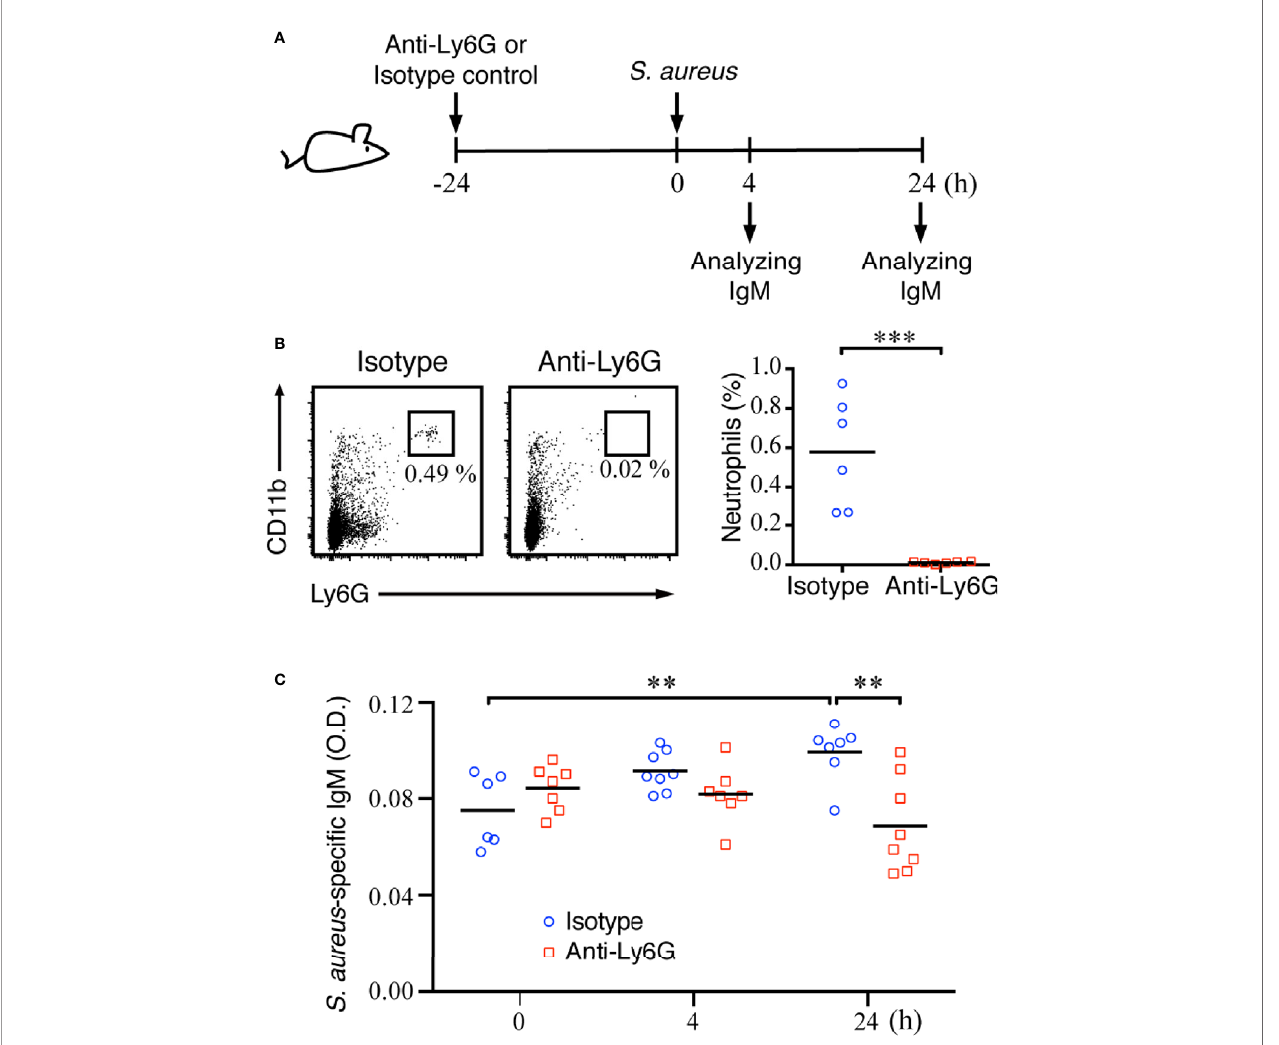
FIGURE 6 | Effect of neutrophil de fi ciency on the activation of MZ B cells and IgM production in S. aureus -infected mice. (A) Schematic diagram of the experimental design. (B) Flow cytometry analysis showing the depletion of neutrophils (Ly6G hi CD11b hi ) in the spleens of C57BL/6 mice at 24 h after an intraperitoneal injection of anti-Ly6G antibody. (C) ELISA analysis showing the levels of S. aureus -speci fi c IgM in the splenic tissue fl uids of C57BL/6 mice injected with isotype control antibody or anti-Ly6G antibody. Results were analyzed by an unpaired Student ’ s t -test. Data are presented as the mean ± SEM (n = 6 in B, and n = 6 – 8 in C). ** p < 0.01 and *** p <